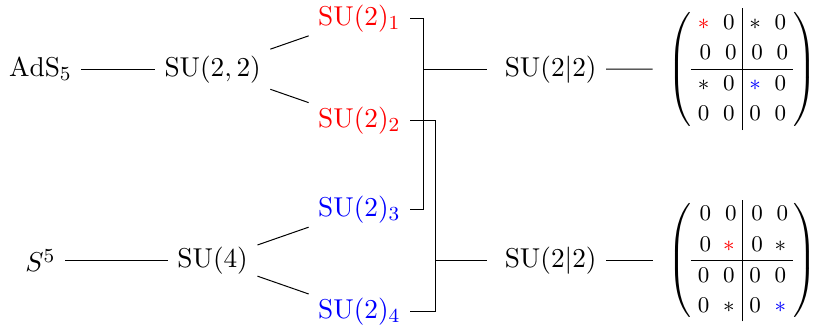
Figure 1 . The structure of the (bosonic) SU(2) (cid:2) 4 subgroup of the stabilizer super